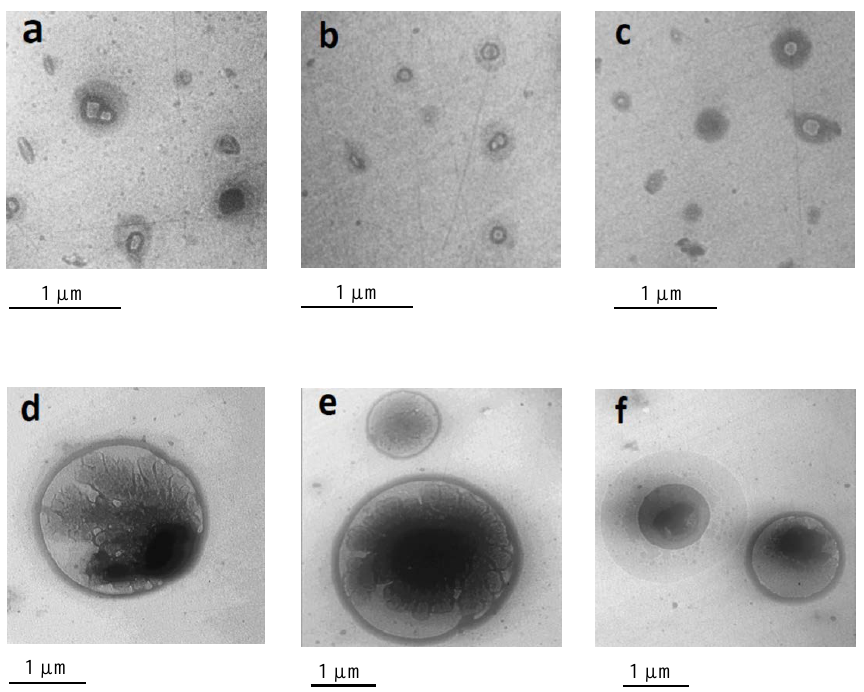
Figure 7. TEM micrographs of submicron (a, b, c) and supermicron (d, e, f) particles.